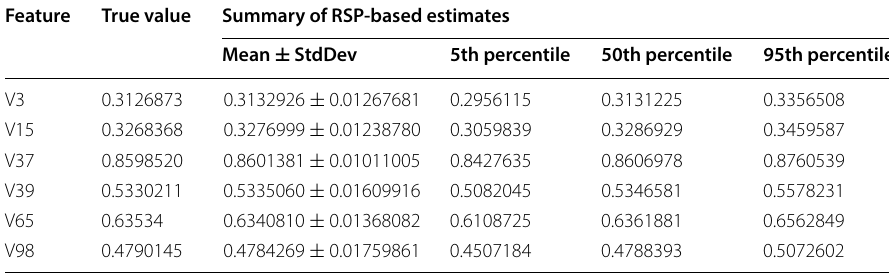
RSP-based coefficients were calculated from a sample of clean RSP blocks ( g = 100